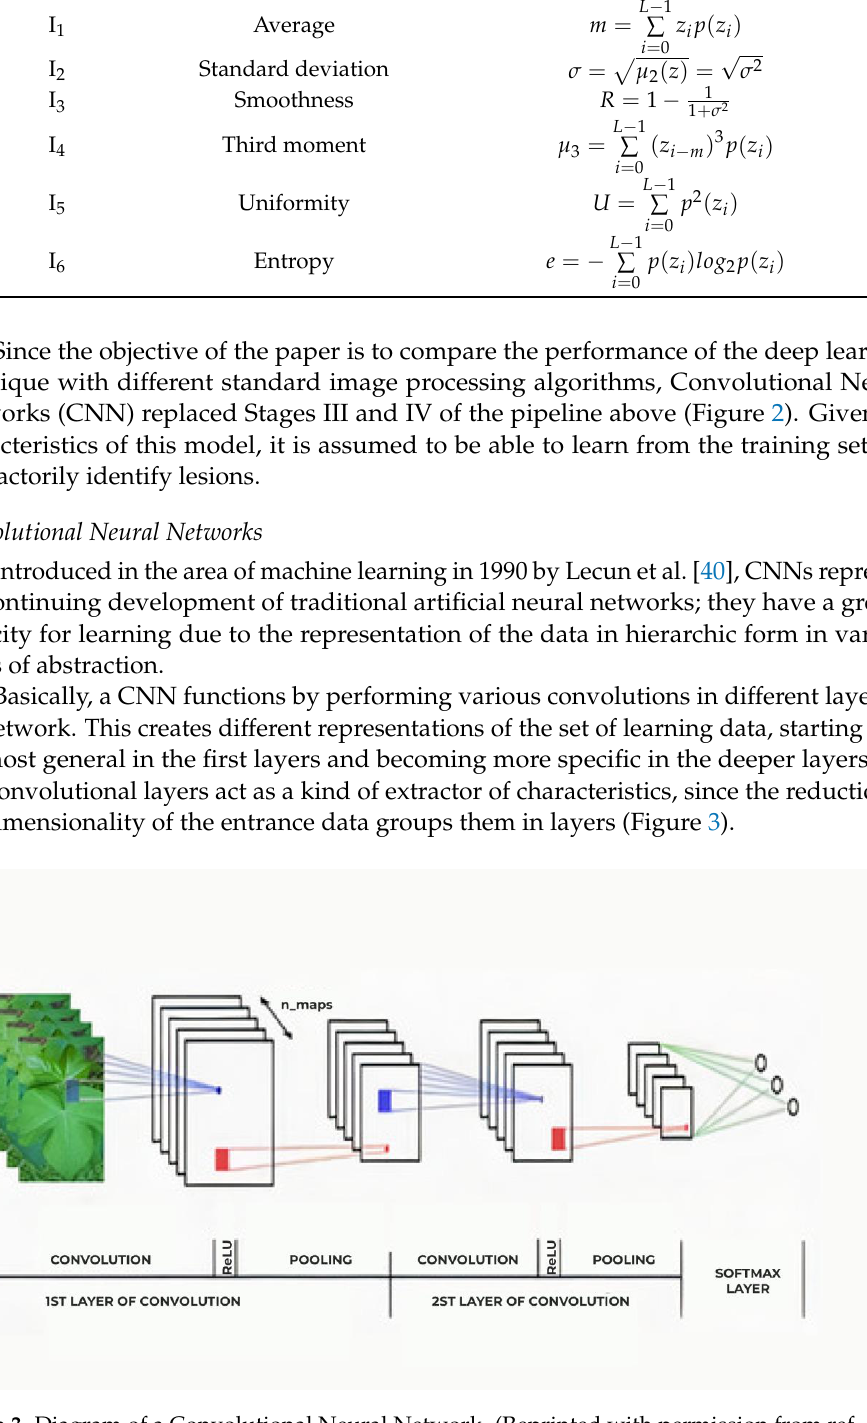
Table 1. Statistical texture attributes.